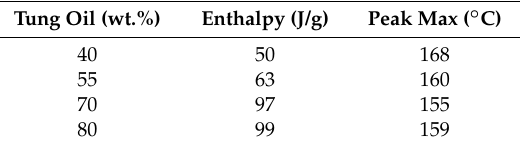
Table 1. Enthalpy associated to exothermic peak and peak max temperatures for differential scanning calorimetry (DSC) curves of products containing 40 wt.%, 55 wt.%, 70 wt.%, and 80 wt.% of tung oil.